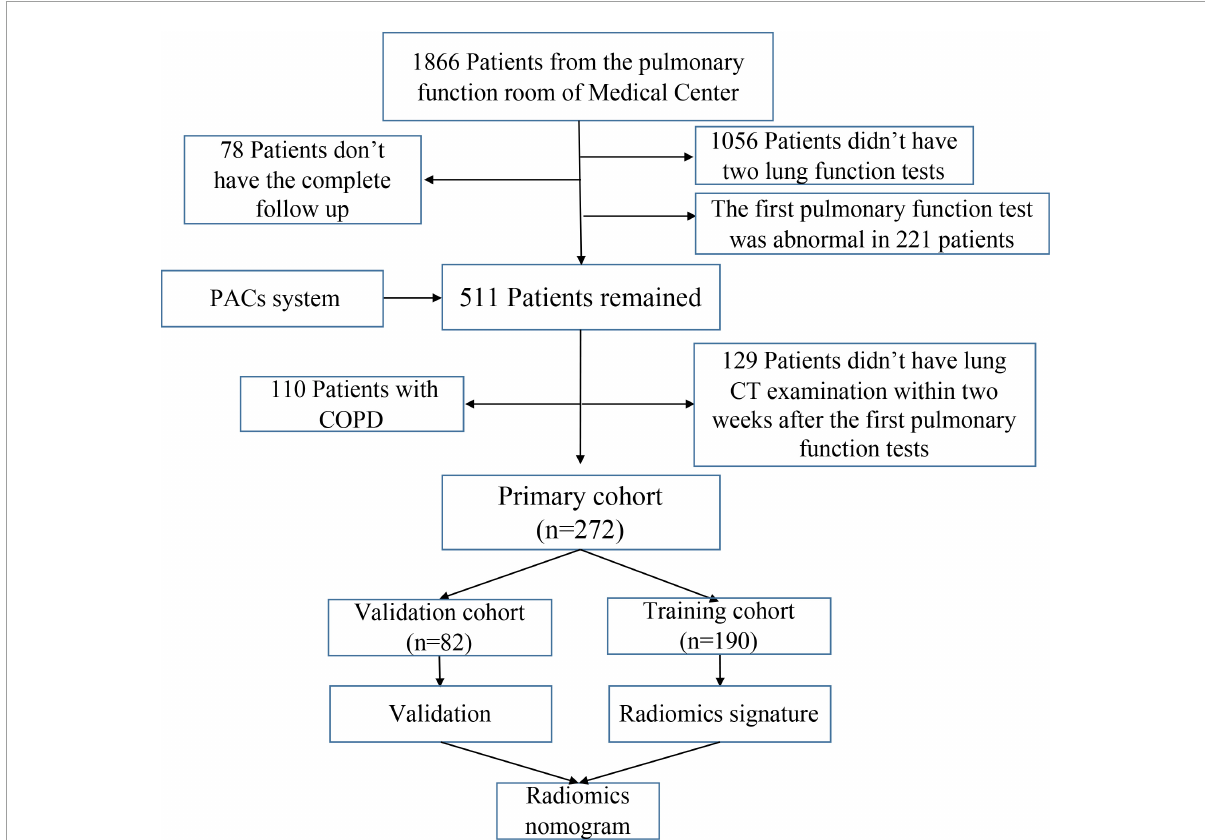
FIGURE2 Flowchart for recruitment of patients in this study (PACS, picture archiving and communication system; COPD, chronic obstructive pulmonary disease; CT, computed